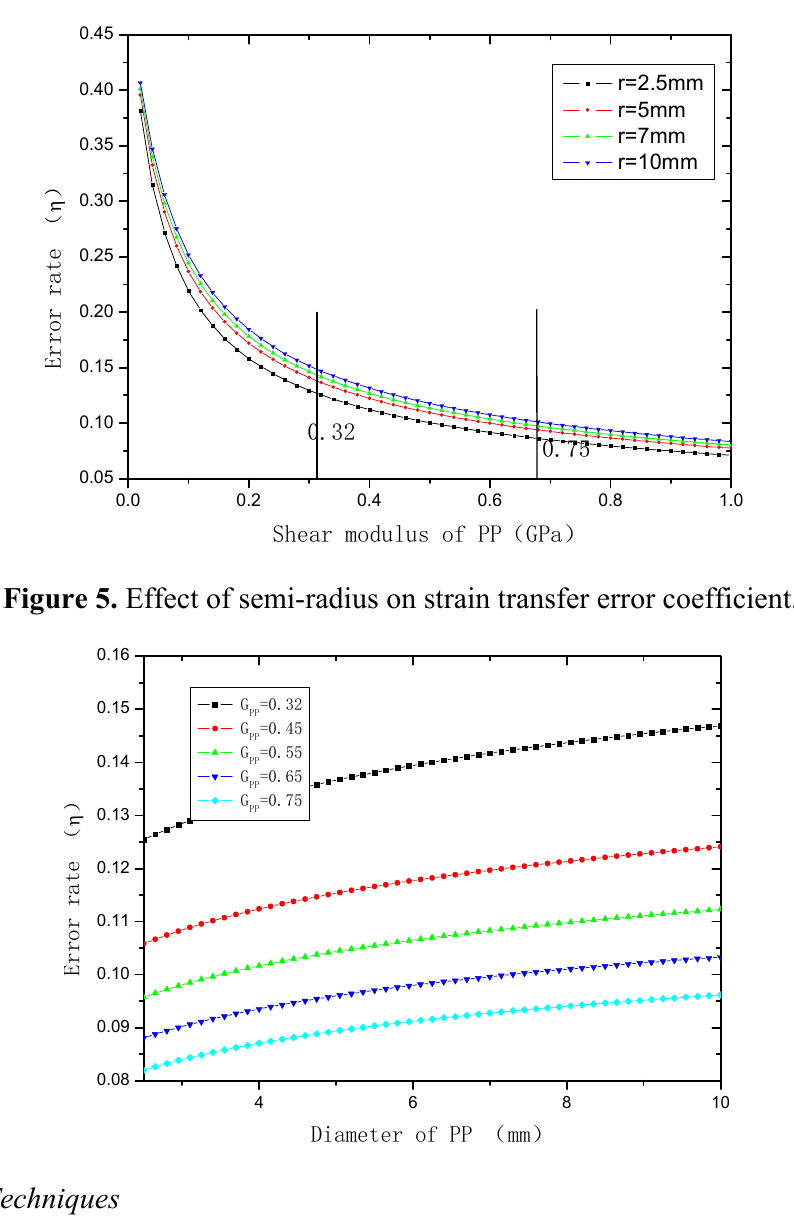
Figure 4. Effect of shear module on strain transfer error coefficient.